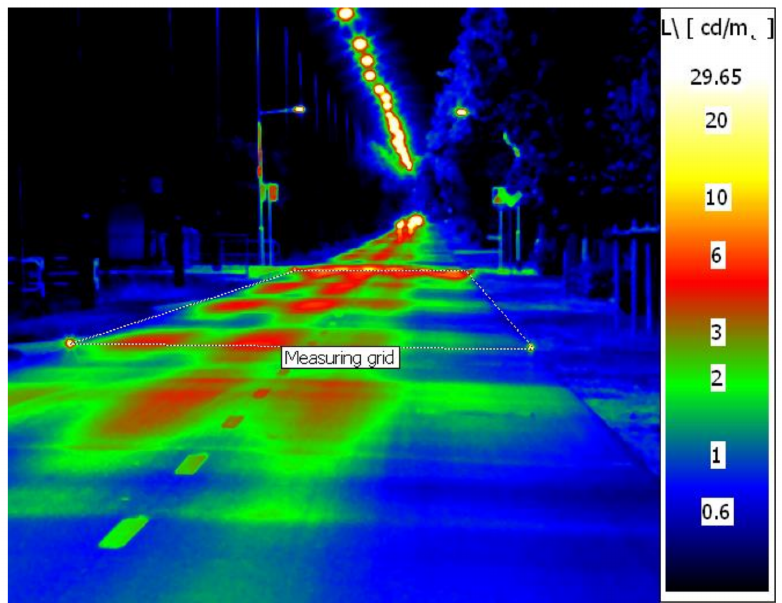
Figure 14. Luminance distribution over the 100 m stretch in front of one of the tested pedestrian crossings (pedestrian crossings no